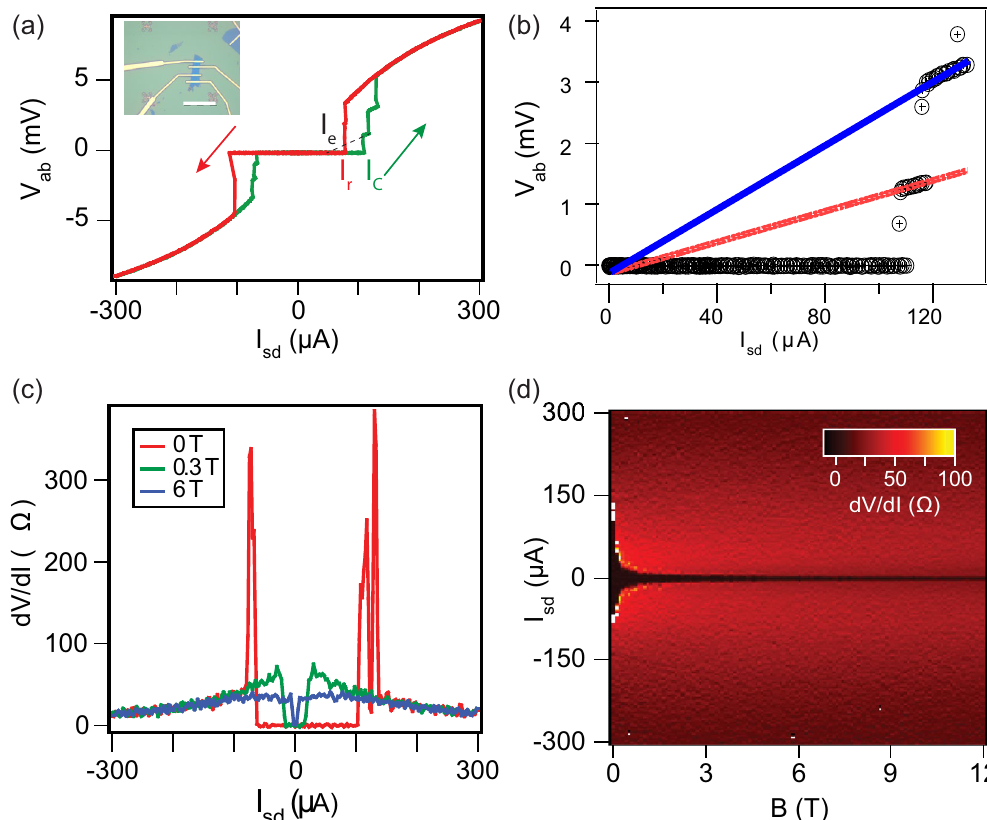
Figure 4. Magnetic field dependent transport properties of exfoliated BSCCO flakes for the device D3. ( a ) Zero field four-probe I-V characteristics at 10 K. (Inset) Optical Image for Device D3. Scale bar corresponds to 40 μ m. ( b ) Similar excess current for the two voltage jumps in IVC taken at 10 K. ( c ) Numerical derivative of IVCs at various B. ( d ) Colorscale plot of numerical derivative, dV/dI as a function of I, from 0 T to 12 T. Superconductivity is observed even at 12 T magnetic field. All magnetic field measurements were performed at 10